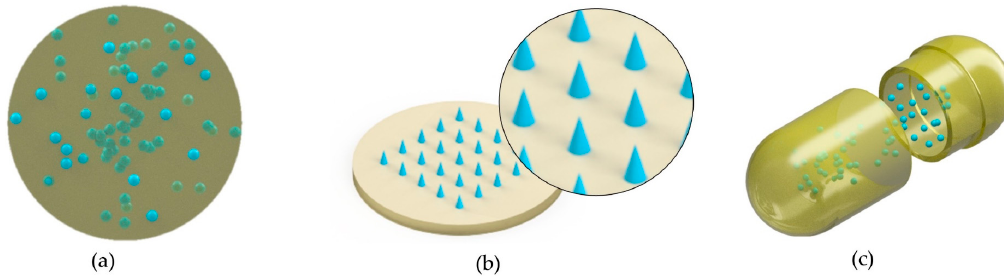
Figure 8. Schematic representation of different drug delivery devices. ( a ) Ultrasonically processed, solid controlled drug release devices reported in Reference [9]; ( b ) Micro-needles for transdermal drug delivery [32]; ( c ) Capsule shells for oral drug delivery [52].